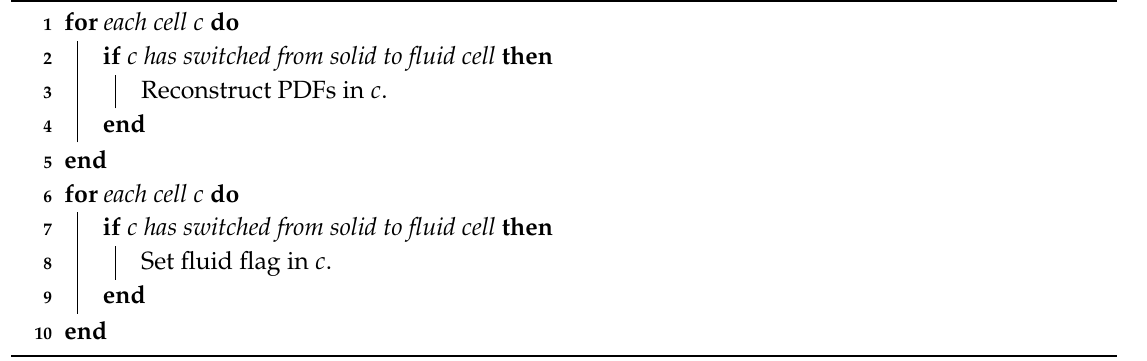
Algorithm 6: Pseudocode for PDF reconstruction (Coup2).